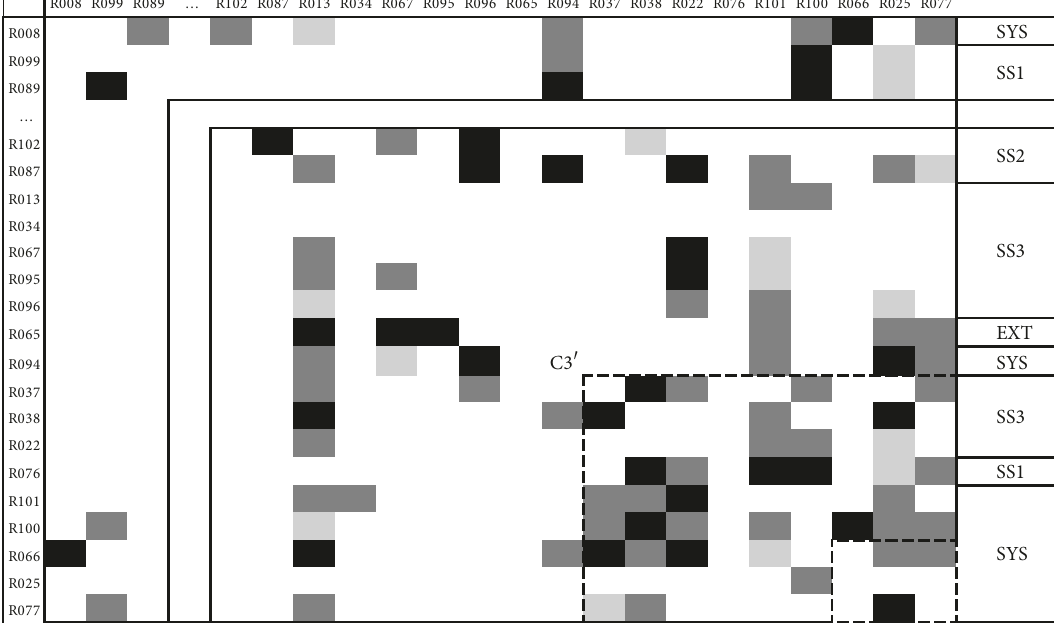
Figure 7: The cluster C 3 and its subcluster C 3 ’ with connections with transverse risks.